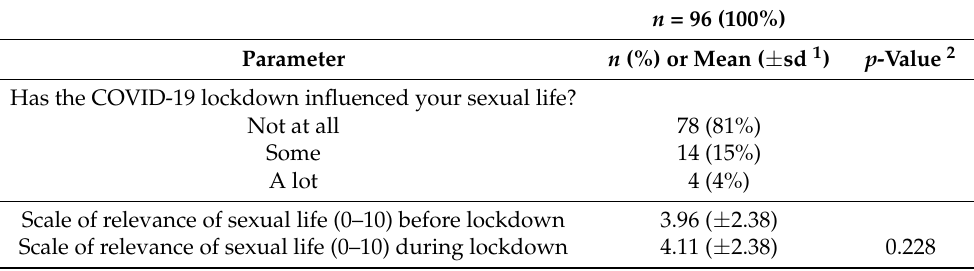
Table 5. Influence of Covid19 lockdown on sexual life. n = 96 (100%) Parameter n (%) or Mean ( ± sd 1 ) p -Value 2 Has the COVID-19 lockdown influenced your sexual life? Not at all 78 (81%) Some 14 (15%) A lot 4 (4%) Scale of relevance of sexual life (0–10) before lockdown 3.96 ( ± 2.38) Scale of relevance of sexual life (0–10) during lockdown 4.11 ( ± 2.38) 0.228 1 sd = standard deviation; 2 p -value for paired t